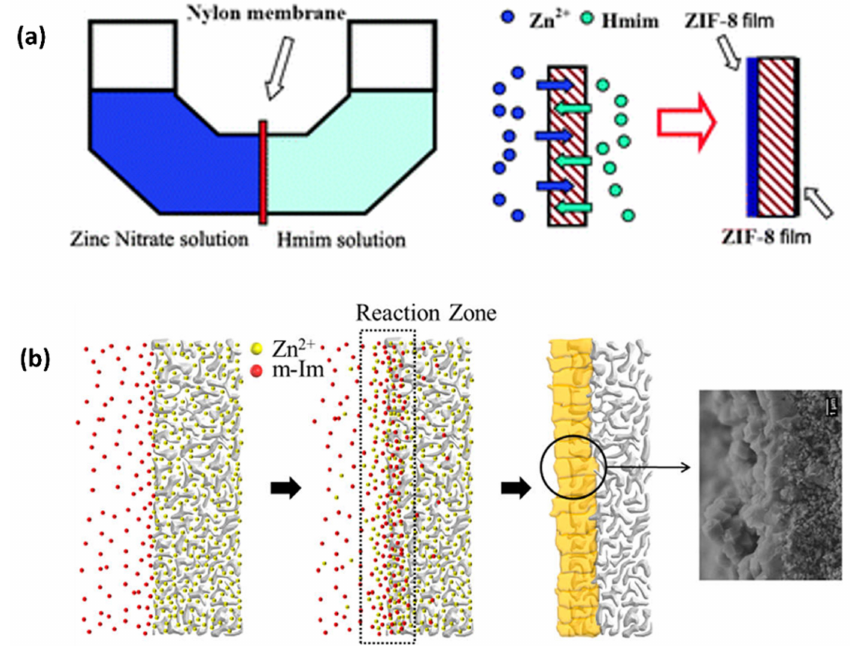
Figure 6. ( a ) Schematic of counter-diffusion synthesis of ZIF-8 membranes. The membranes form on both sides of the nylon support via counter-diffusion of Zn 2+ and 2-methylimidazole through the pores of the nylon support [86]. ( b ) Scheme of the counter-diffusion-based in situ membrane synthesis method [87]: (1) A porous support pre-saturated with the zinc precursor is placed in the ligand solution containing sodium formate; (2) the diffusion of zinc ions and ligand molecules in the opposite directions forms a “reaction zone” near the support surface; and (3) rapid